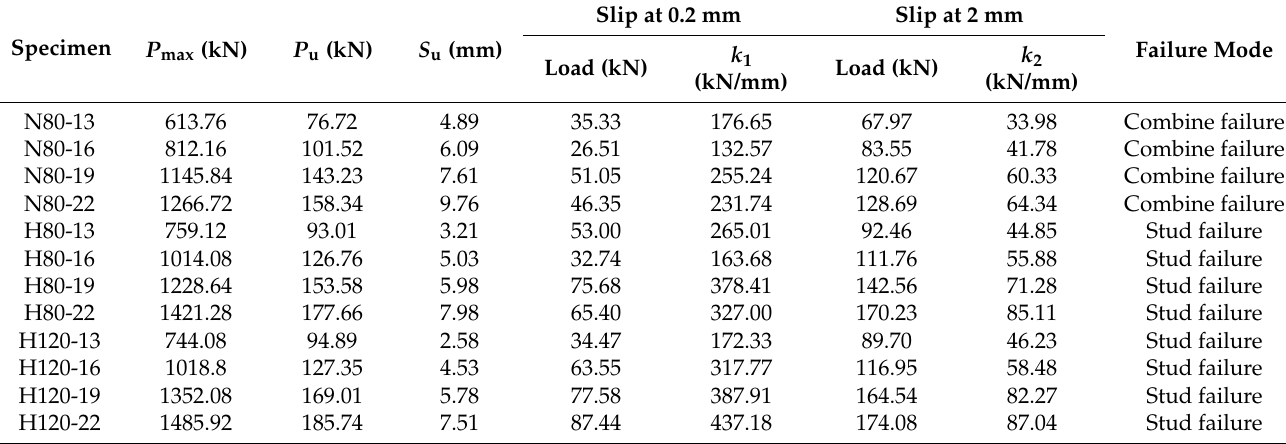
Table 5. Push-out test results.